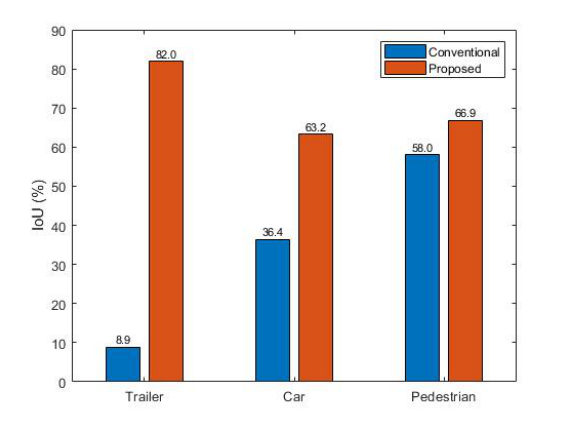
Figure 9. Detection performance comparison between conventional and our proposed